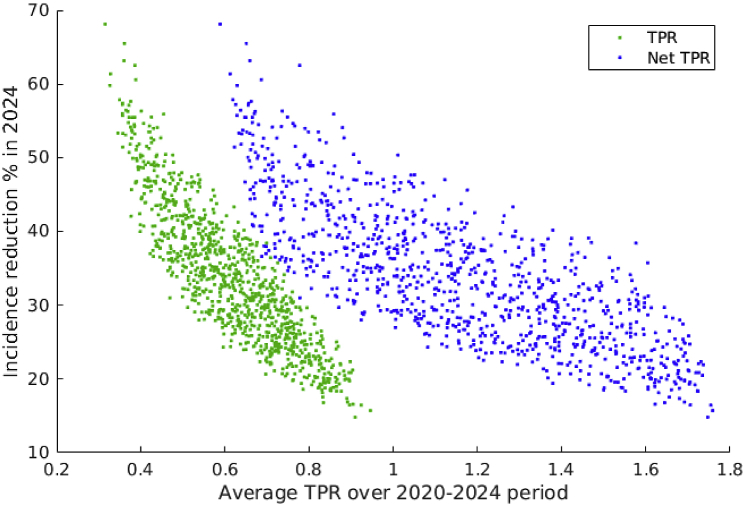
Comparison between TPR definitions. Scatterplot of average TPR vs HIV incidence in 2024, assuming that the “universal first” strategy is implemented. Green dots represent results using the definition from the main analysis while blue dots represent results using the alternative definition (net TPR) using net ART increase as denominator.)